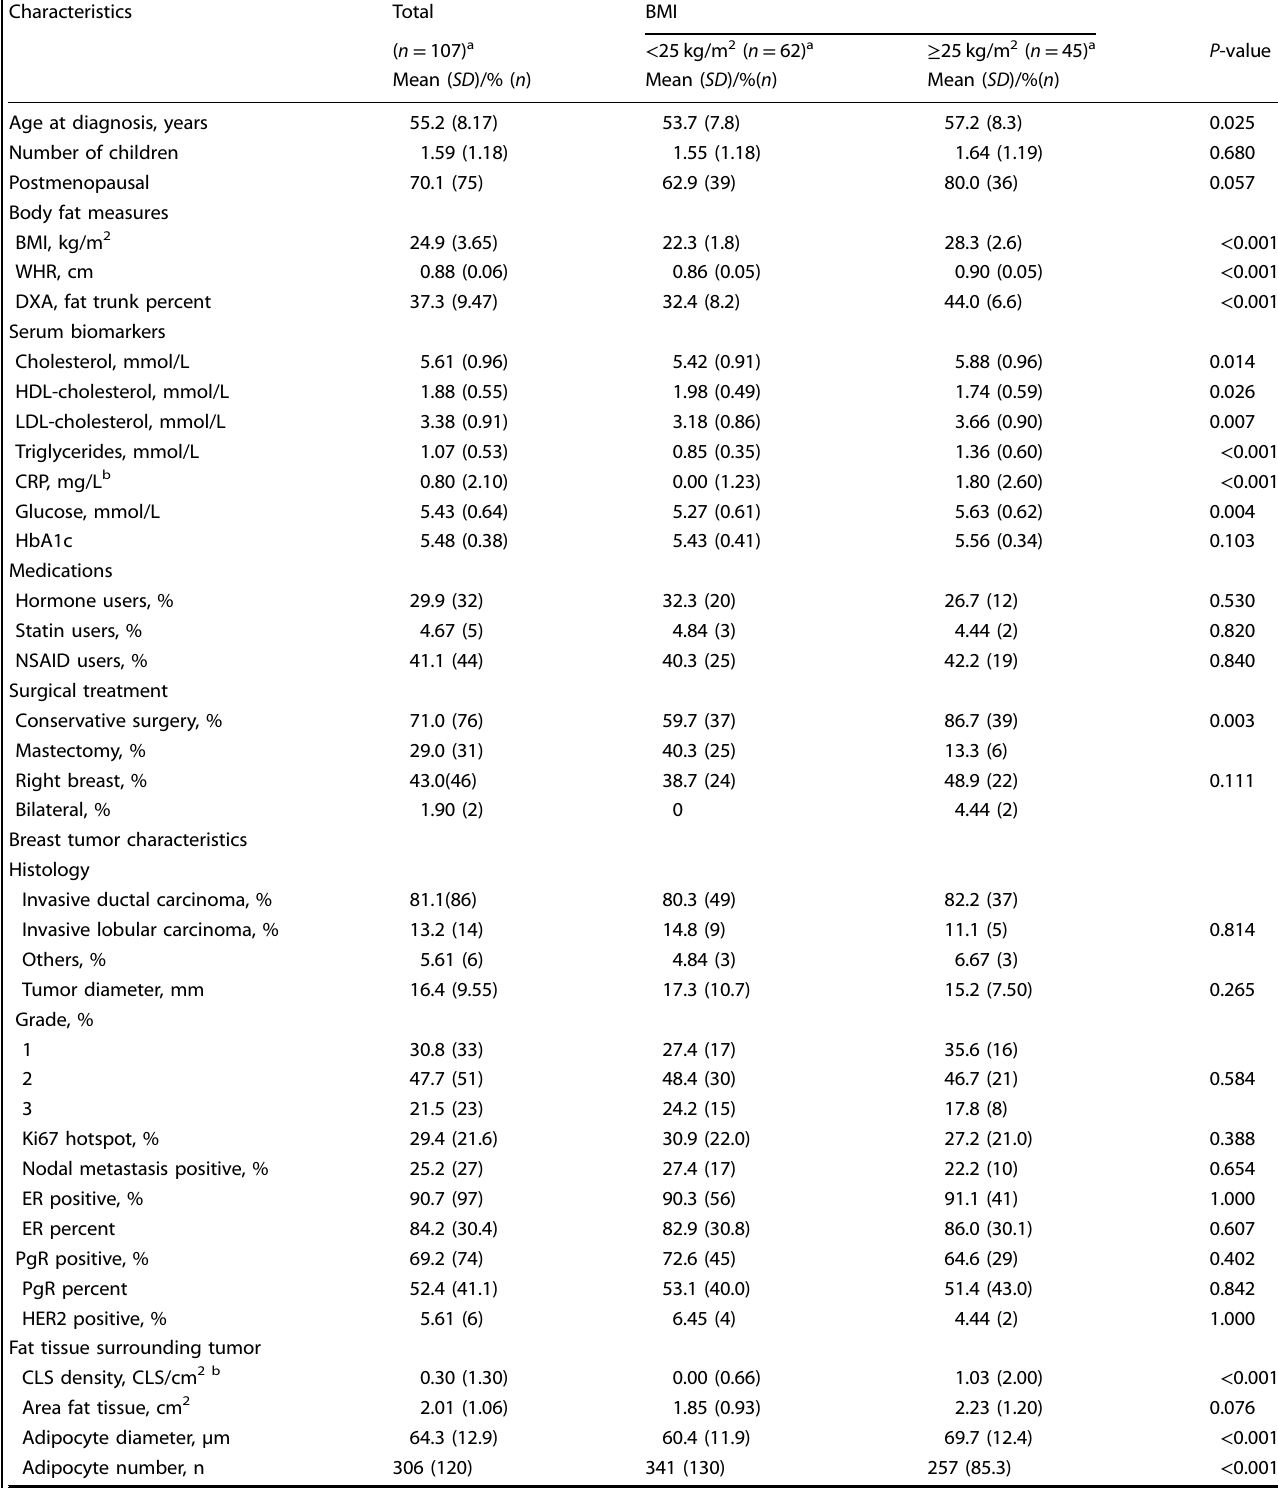
Table 1. Characteristics of the breast cancer patients (hosts) and the breast tumors, overall and strati fi ed by BMI; presented as means (SD) or % (n)